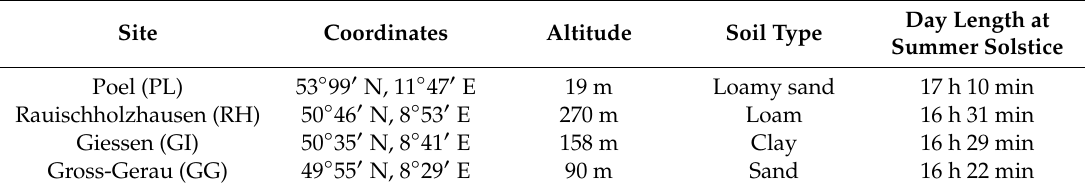
Table 2. Geographical data of the di ff erent experimental